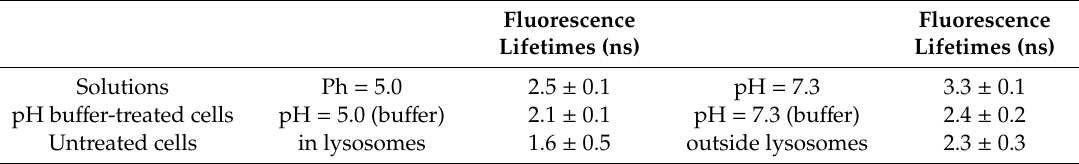
Table 1. Comparison of fluorescence lifetimes of the CDs under di ff erent